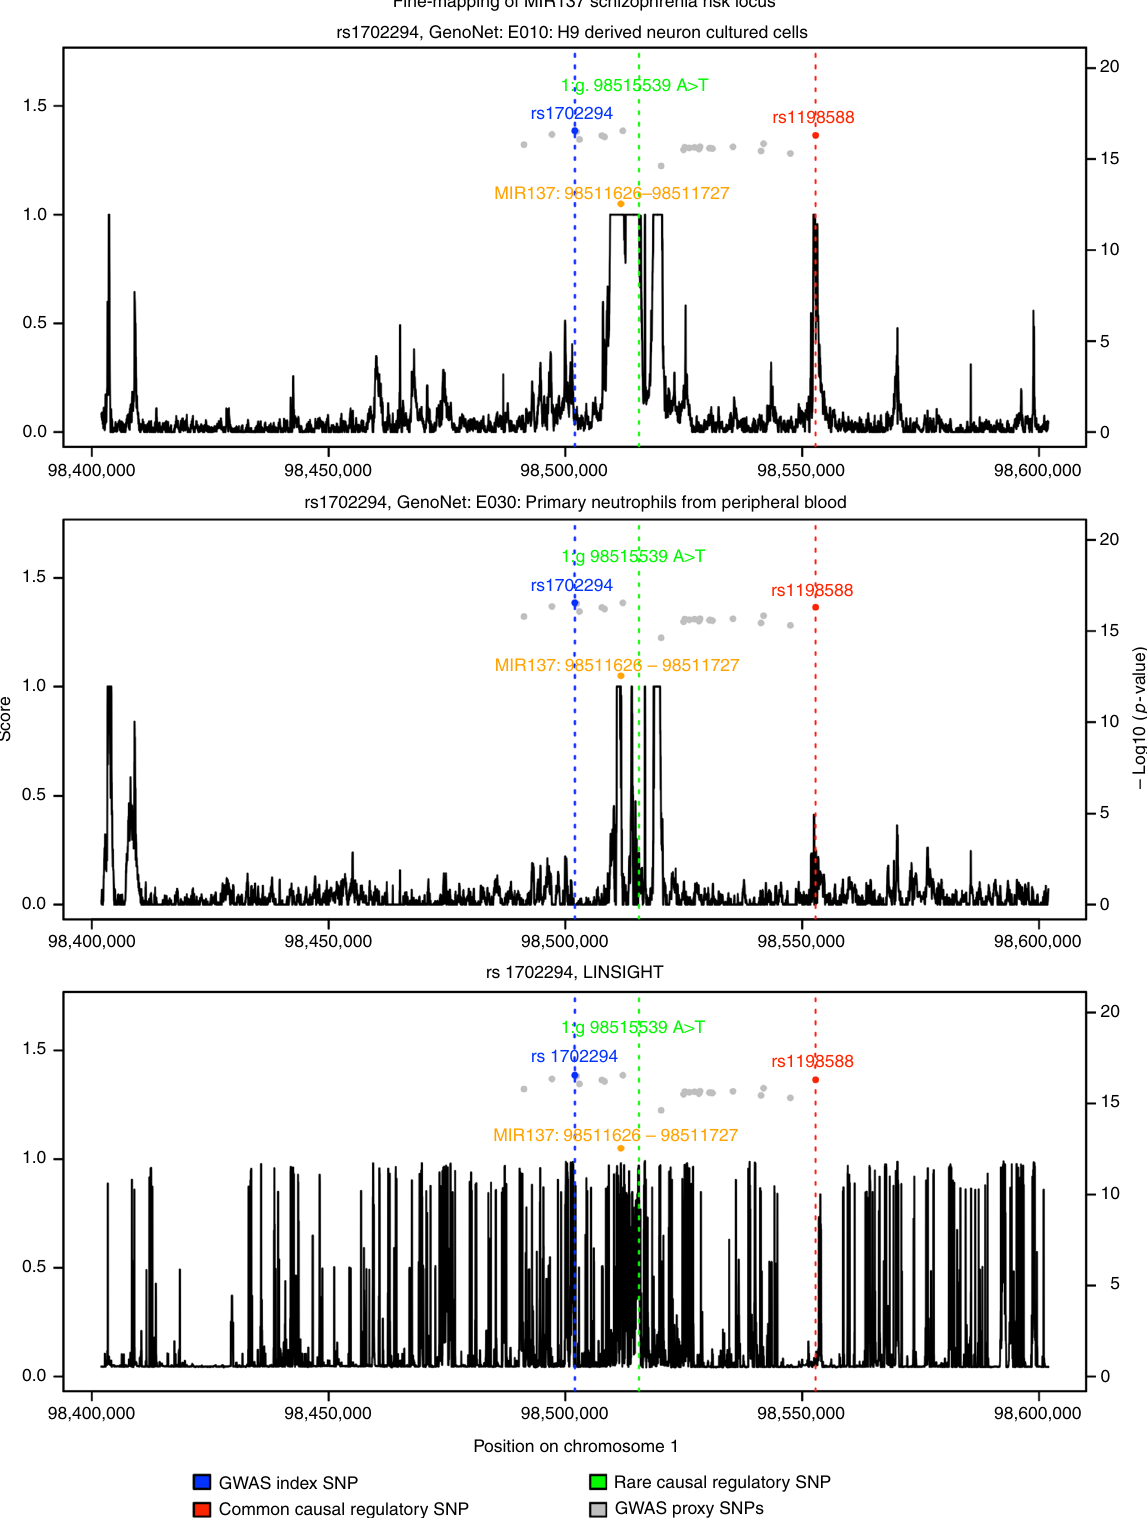
Fig. 6 Fine-mapping of MIR137 schizophrenia risk locus. The plots present GenoNet predictions in a 200-Kb region centered at the GWAS index SNP at this locus, rs1702294, in H9-derived neuronal cultured cells as well as in primary neutrophils from peripheral blood. In addition, we show predictions in this region from LINSIGHT, an organism-level functional prediction approach. 1:g.98515539A > T is a known rare causal variant in